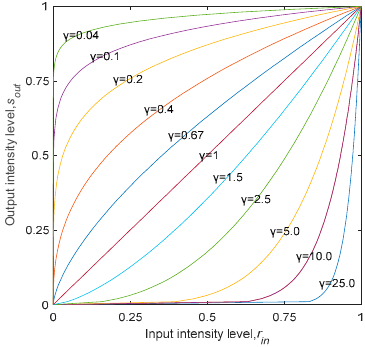
Figure 9. Gamma transformation curve.